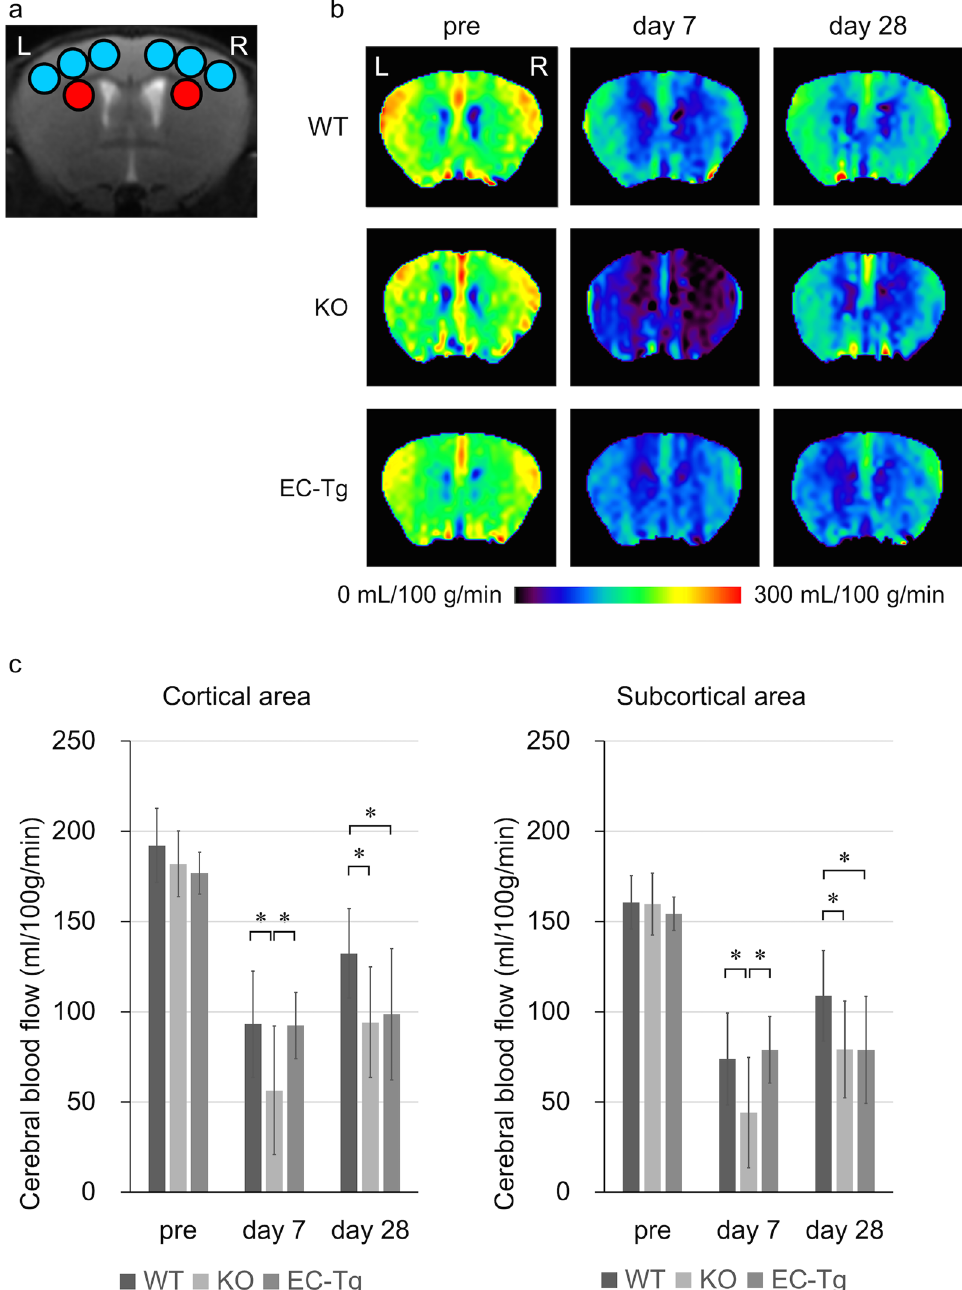
Figure 2. Temporal profiles of cerebral blood flow (CBF) of mice with bilateral common carotid artery stenosis (BCAS). ( a ) Regions of interest (ROIs) used in the analyses of CBF images obtained from arterial spin-labelling magnetic resonance imaging. The CBF values in the cerebral cortex and the subcortical area were calculated from the six blue and two red ROIs, respectively. ( b ) Representative coronal CBF images obtained from arterial spin labelling in WT, KO and EC-Tg mice. ( c ) Temporal profiles of CBF presented as absolute values (mL/100 g/min) in the cortical and subcortical parenchymal areas. A column with a bar represents mean ± SD of CBF. Two-way repeated measures ANOVA was conducted for CBF values between genotypes and time interaction terms. In the cortical area, genotypes significantly affected the CBF values ( p = 0.012) and the interaction was marginally significant ( p = 0.066). In the subcortical area, both genotypes ( p = 0.049) and interaction ( p = 0.014) were significant. Additionally, in both the cortical and the subcortical areas, there were significant differences in the CBF values between the three genotypes using one-way ANOVA on day 7 (Cortical, p = 0.045; Subcortical, p = 0.046 (WT, n = 15; KO, n = 7; EC-Tg, n = 8)) and day 28 (Cortical, p = 0.035; Subcortical, p = 0.048 (WT, n = 14; KO, n = 5; EC-Tg, n = 8), but not pre-surgery (pre) (Cortical, p = 0.17; Subcortical, p = 0.61 (WT, n = 15; KO, n = 8; EC-Tg, n = 8)). On day 7, CBF in KO mice was significantly decreased compared with the other genotypes according to Tukey’s test. On day 28, CBF in KO and EC-Tg mice was significantly decreased compared with WT mice; * p <